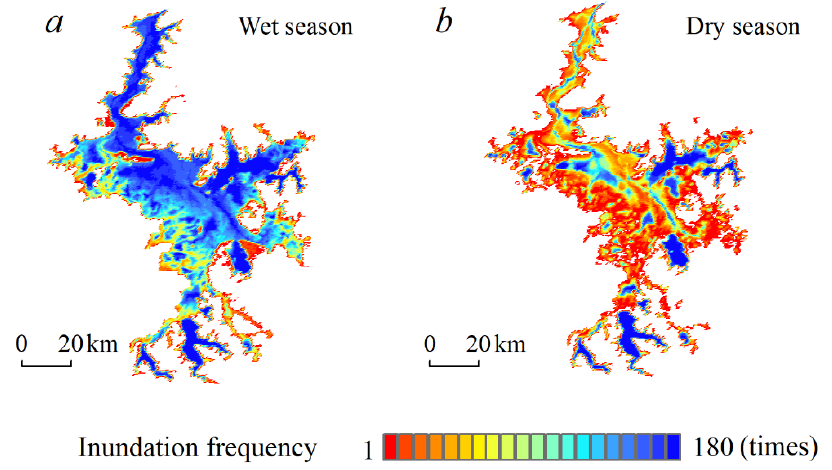
Figure 6. The inundation frequency of Poyang Lake in the wet ( a ) and dry ( b ) seasons during